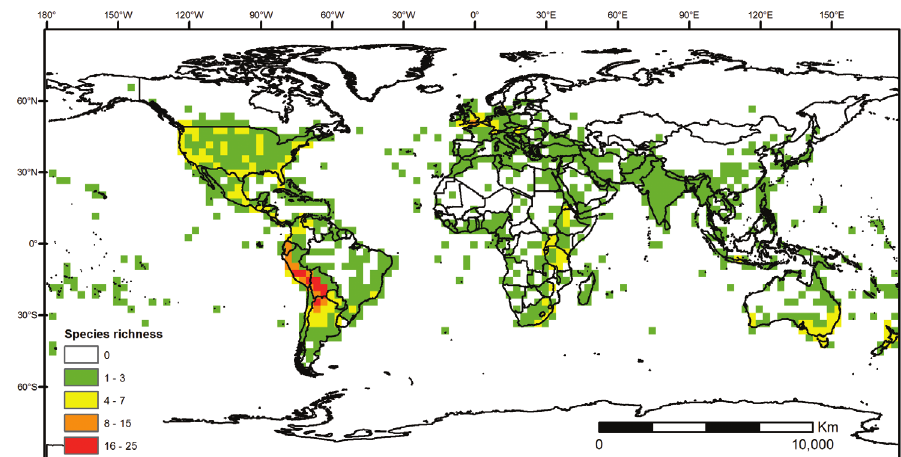
Figure 1. Global distribution of the Morelloid Clade of Solanum , showing number of species per 3 de- gree grid cells (ca. 300 km 2 ) based on native and non-native